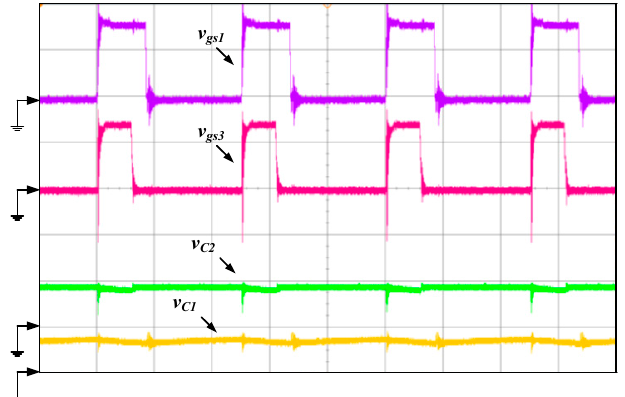
Figure 13. The practical waveforms of the voltages across active switches.